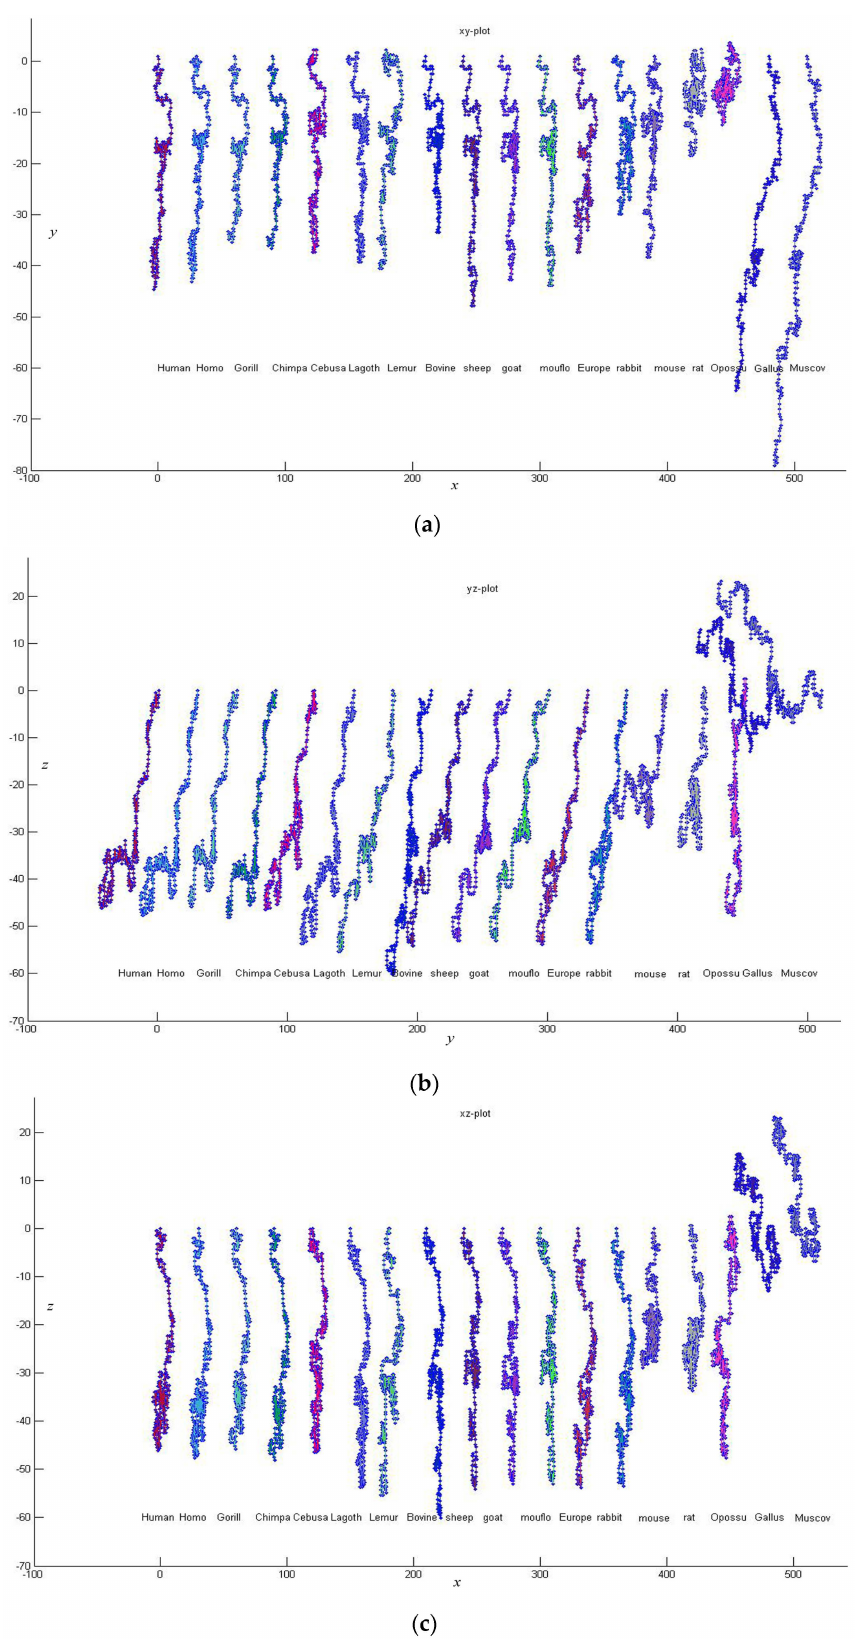
Figure 2. ( a ) The projection on the xy -plane of 3-D curves of 18 DNA sequences; ( b ) The projection on the yz -plane of 3-D curves of 18 DNA sequences; ( c ) The projection on the xz -plane of 3-D curves of 18 DNA